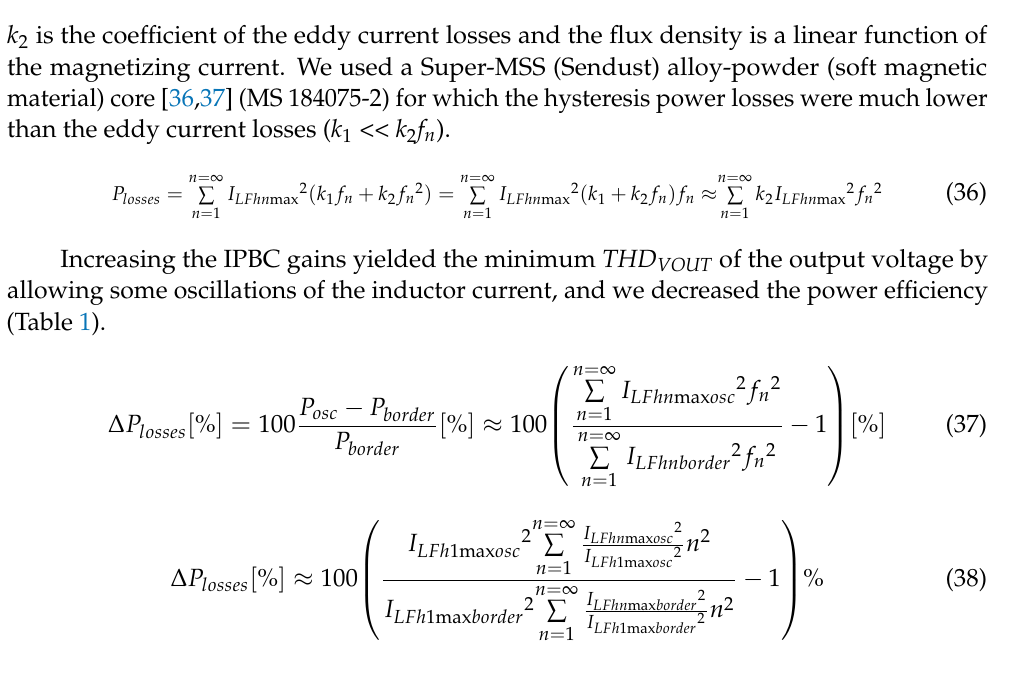
Table 1. Simulation results: Comparison of the inverter output voltage parameters with the three switching frequencies for the border gains and above the border gains for a nonlinear rectifier RC load (three-level, double edge, the first scheme PWM modulation); C F = 50 µ F, L F = 1 mH, R LF = 1 Ω , and M = 0.5; RC load: R = 100 Ω , C = 430 µ F, dynamic loads (500||50)/500 Ω